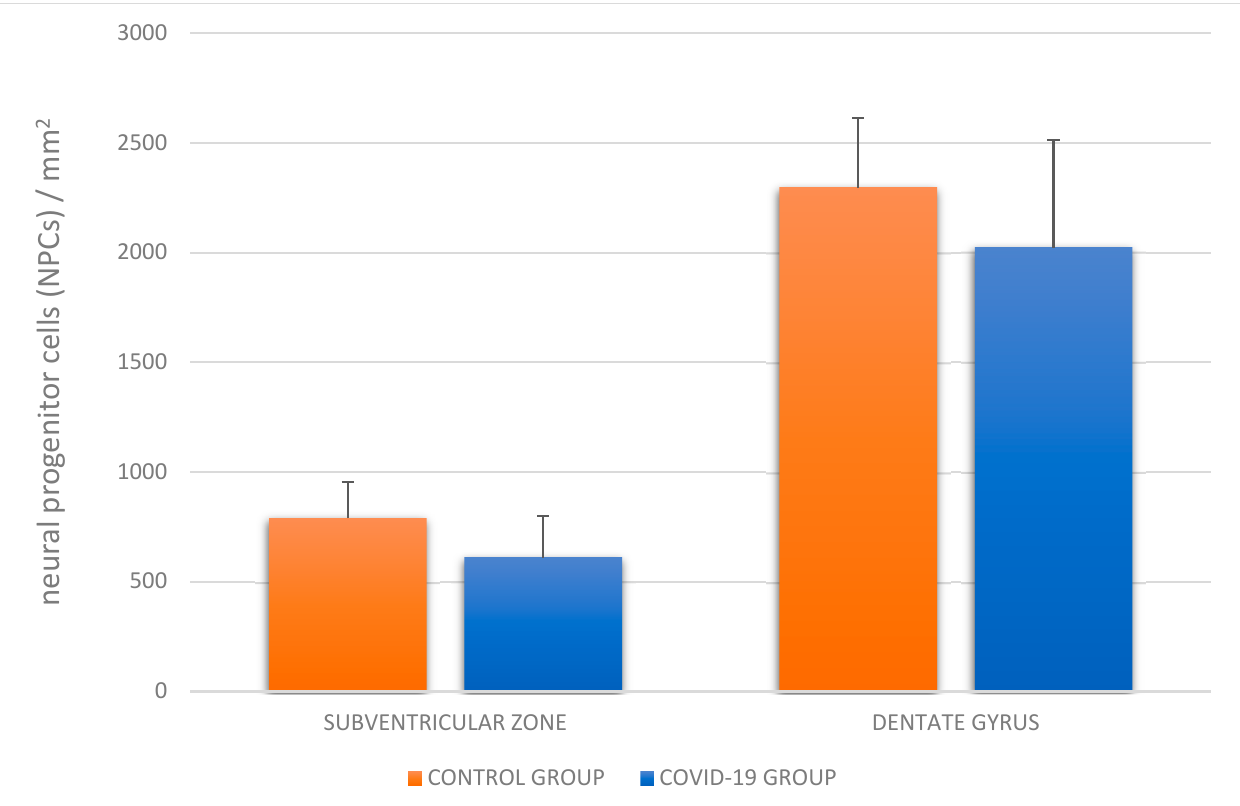
Figure 4. Density of neural progenitor cells (NPCs) in the hippocampal dentate gyrus and subven- tricular zone in the control group and group of patients with diagnosed COVID-19.